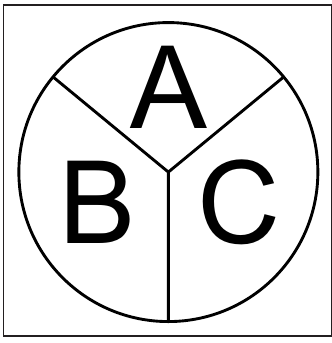
Figure 4: Tamil Triglossia (simplified form of Figure